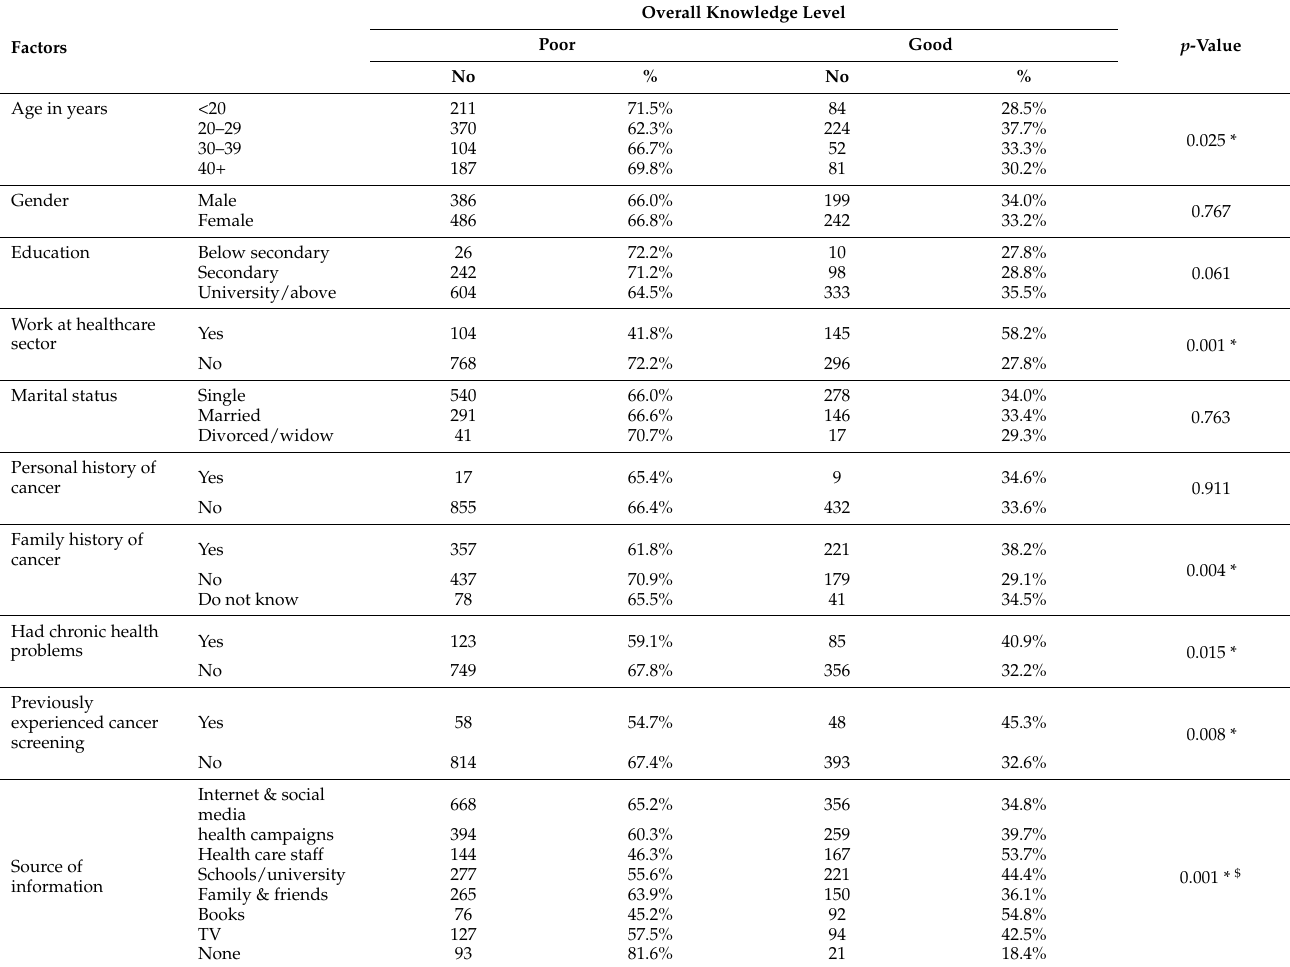
Table 4. Factors associated with public knowledge regarding cancer and cancer screening, Saudi